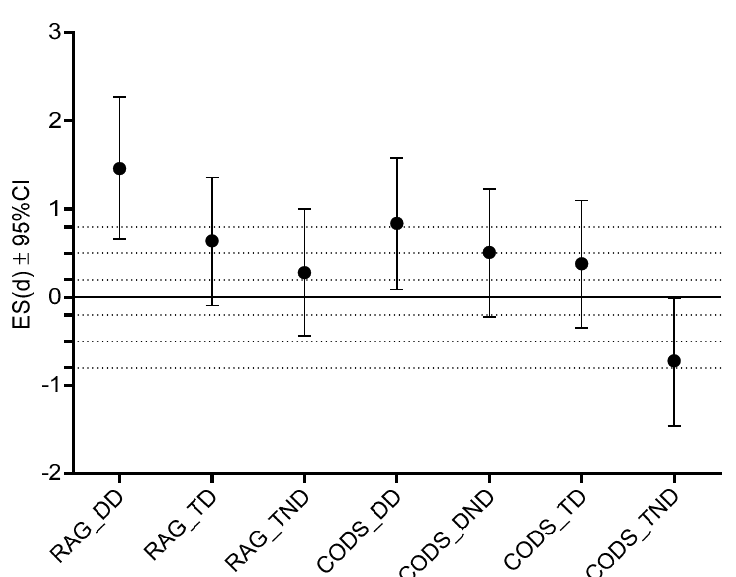
Figure 2. The effect size differences (ES; Cohen’s d) with 95% confidence intervals (95%CI) between the top-level and the team-level players (RAG_DD—reactive agility performed with dribbling on dominant side, RAG_TD—reactive agility performed with ball touching on the dominant side, RAG_TND—reactive agility performed with ball touching on the non-dominant side, CODS_DD— change-of-direction-speed performed with dribbling on dominant side, CODS_DND—change-of- direction-speed performed with dribbling on non-dominant side, CODS_TD—change-of-direction- speed performed with ball touching on dominant side, CODS_TND—change-of-direction-speed performed with ball touching on non-dominant side), < 0.2 trivial ES, 0.21–0.49 small ES, 0.50–0.79 medium ES, >0.79 strong ES.